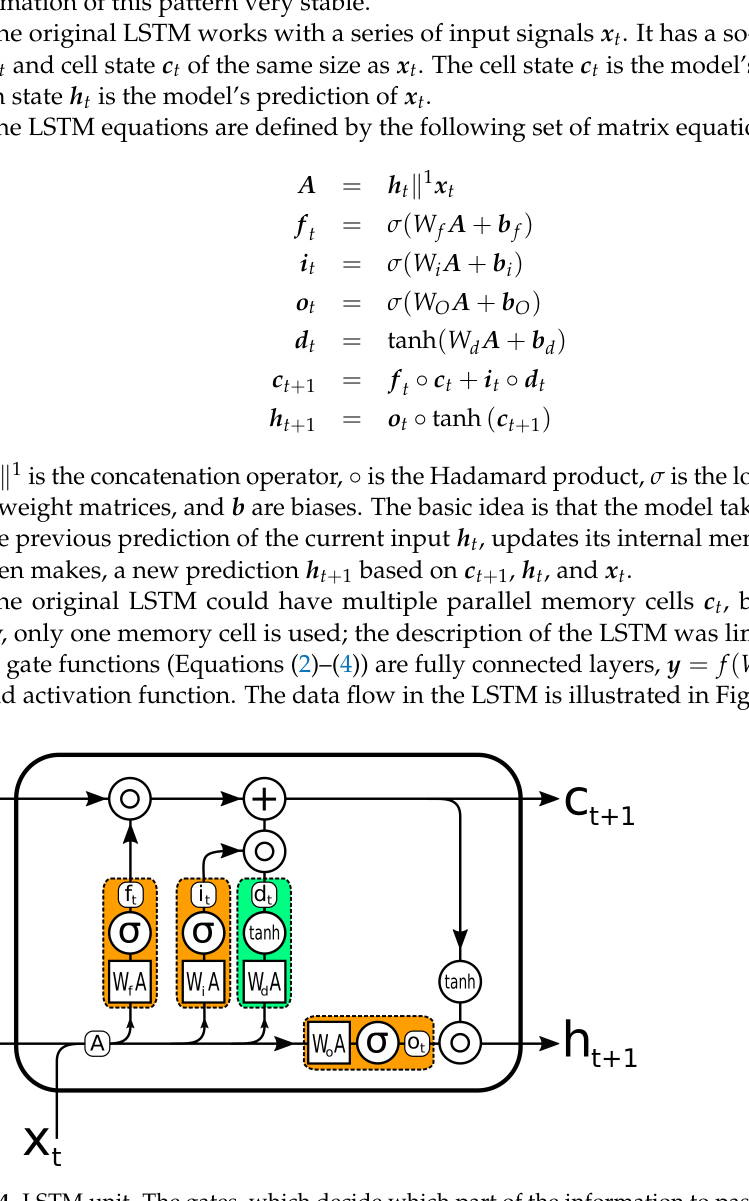
Figure 4. LSTM unit. The gates, which decide which part of the information to pass on, are orange. Green is the update to the memory